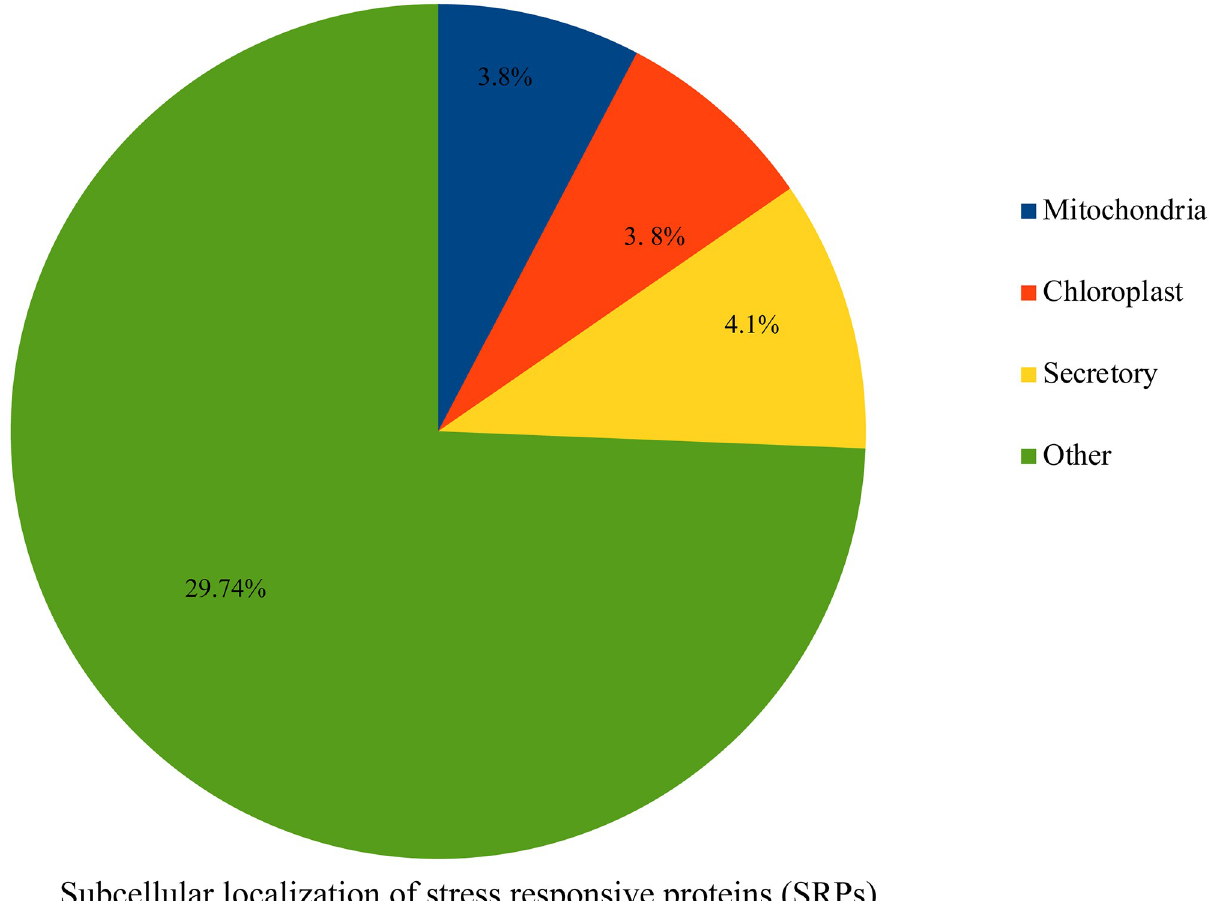
Fig 5. Sub-cellular localization of stress responsive proteins as predicted using